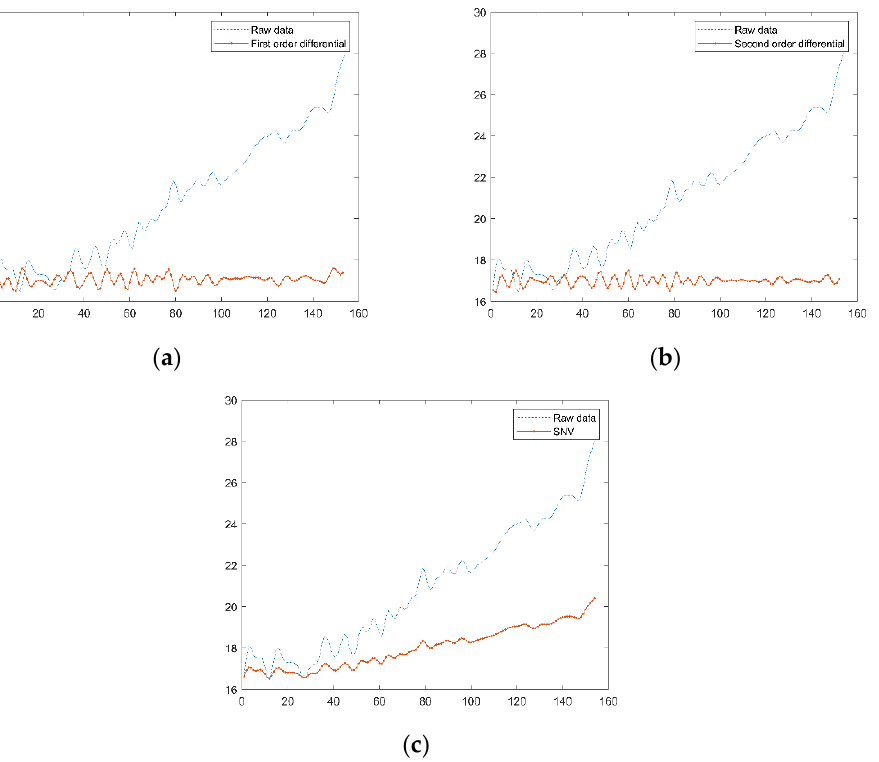
Figure 6. Spectral curves after pre-treatment. ( a ) first-order differentiation, ( b ) second-order differentiation, ( c ) standard normal variable transformation.